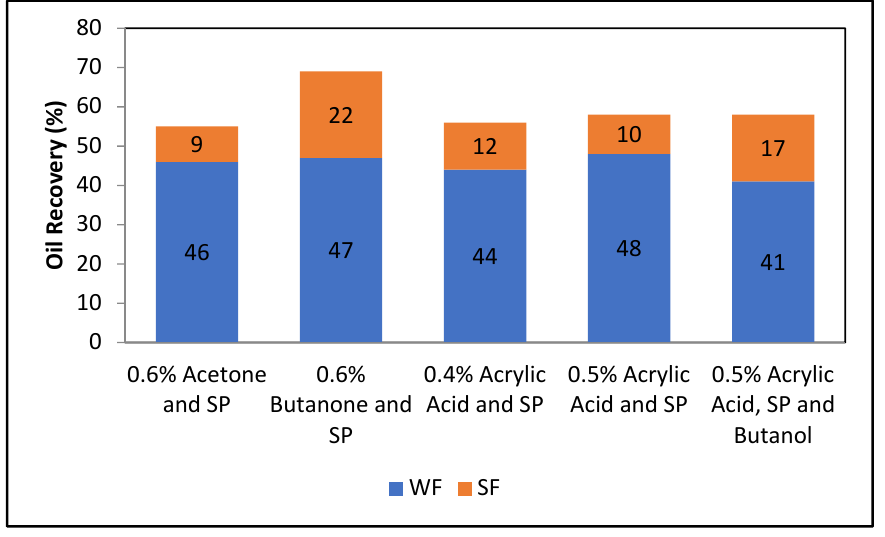
Figure 18. Comparison of total oil recovery observed from the five formulations.